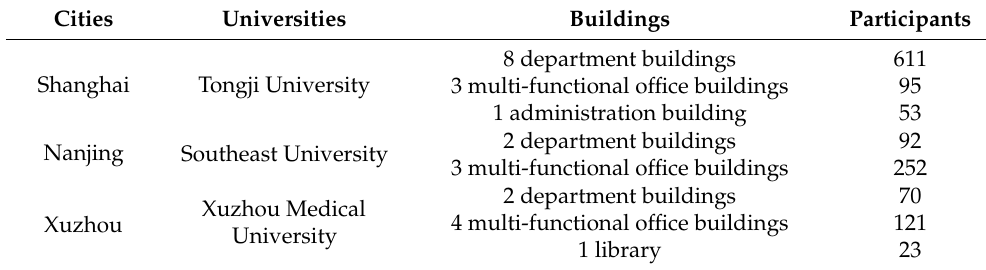
Table 4. Evaluated buildings in the POE-based field survey.